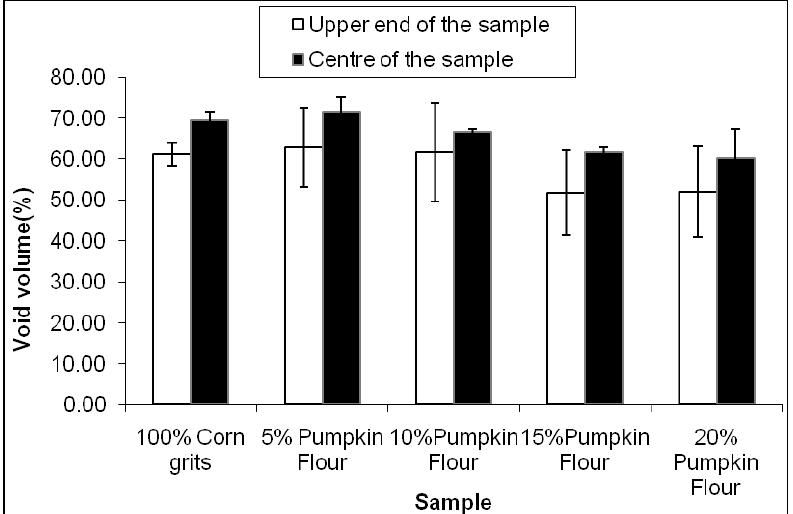
Figure 8. Effect of varying pumpkin flour at constant screw speed (250 rpm) on bubble area distribution at the upper end and centre of the extruded expanded